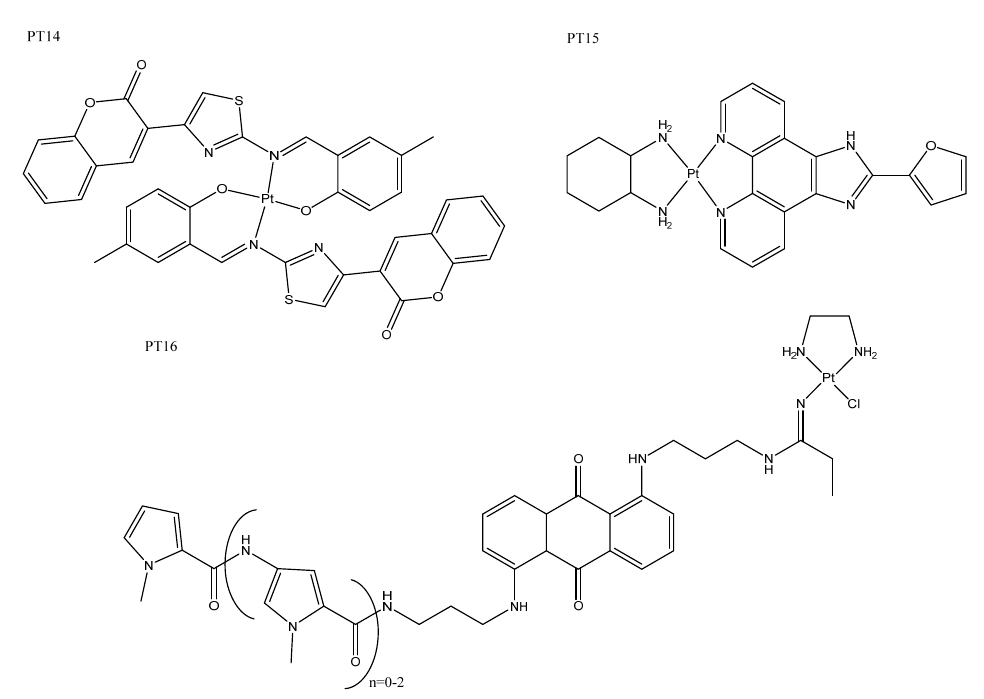
Figure 10. Platinum complexes with fluorescent moieties: PT13 [84]; PT15 Pt(II) imidazole phenan- throline complex [86]; and PT16 polyamide conjugated complex, where n = 2 [87]. Table 3. A summary of the IC 50 values, luminescent properties, and special features of platinum- based luminescent anticancer complexes. Cyclometallated complexes PT17a, where R’ = H, and PT17b, where R’ = F [88]; Pt(II) imidazole phenanthroline complex PT15 [86]; platinum-decorated nanoparticle PT9 [79]; dual-platinum-center platinum(II) diethienylcyclopentene PT6 [76]; square planar Pt(II) with weak photosensitizer PT2 [72]; and polyamide conjugated complex PT16 [87]. Luminescence Special